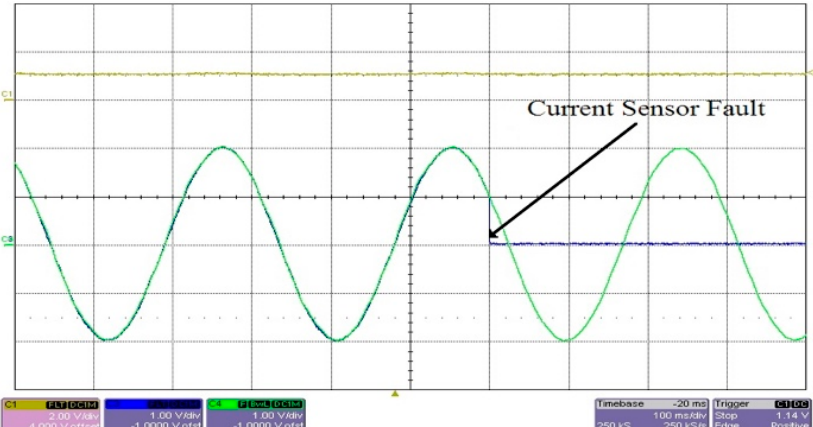
Figure 10. Experimental result: all current sensors fail—steady state at 100 rpm, no load. Measured rotor speed (yellow), measured (blue) and estimated (green) a-phase stator current. Scales: speeds— 200 rpm/div; currents—1 A/div; time—100 ms/div.